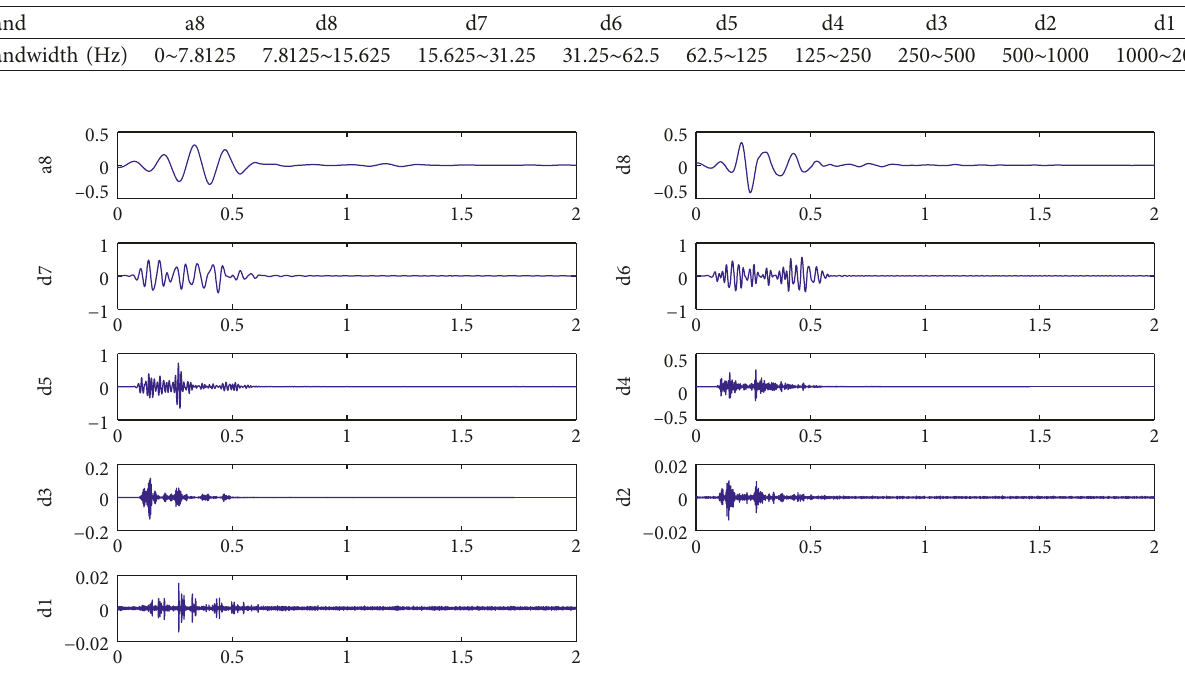
Table 5: Bandwidth distribution of measured seismic wave.